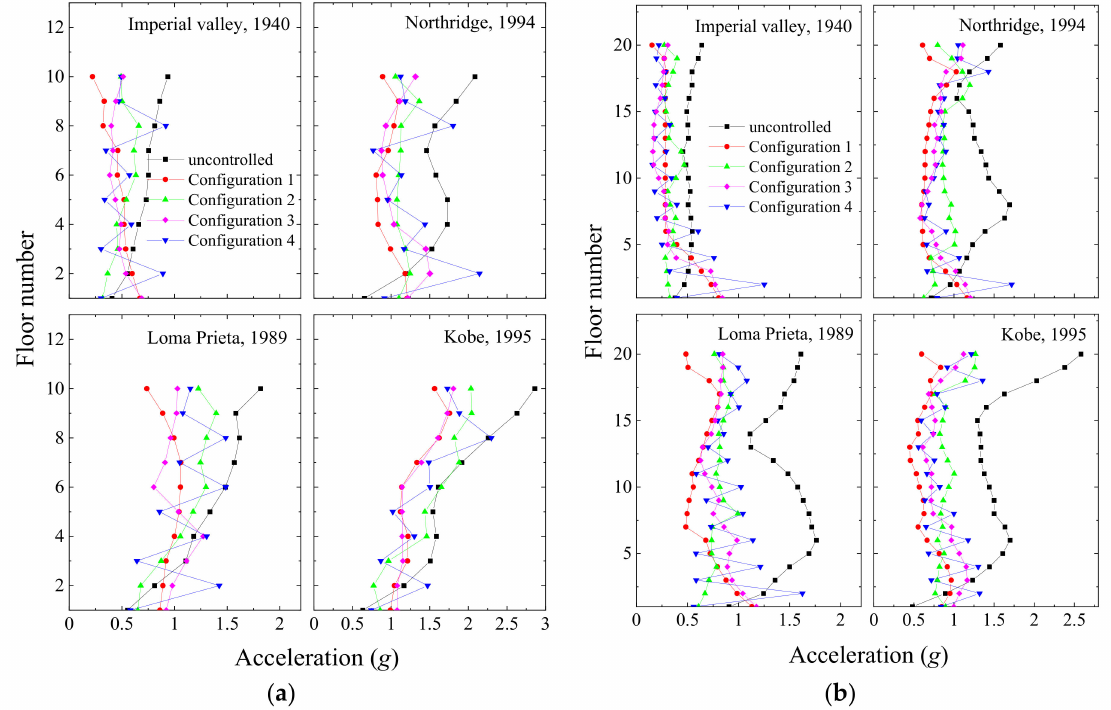
Figure 15. Peak floor acceleration under different damper configurations in: ( a ) a coupled stiff building and ( b ) a coupled flexible building under semi-active control of the MR